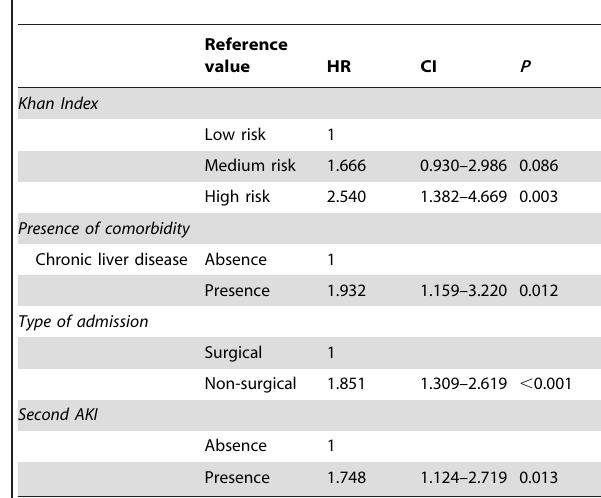
Table 3. Final Cox model.